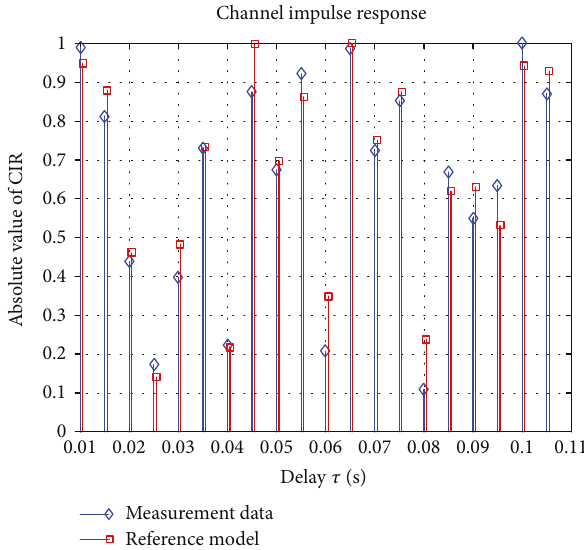
Figure 4: Power-delay pro fi le of the channel for low moving speed of vehicles (Tx/Rx): v